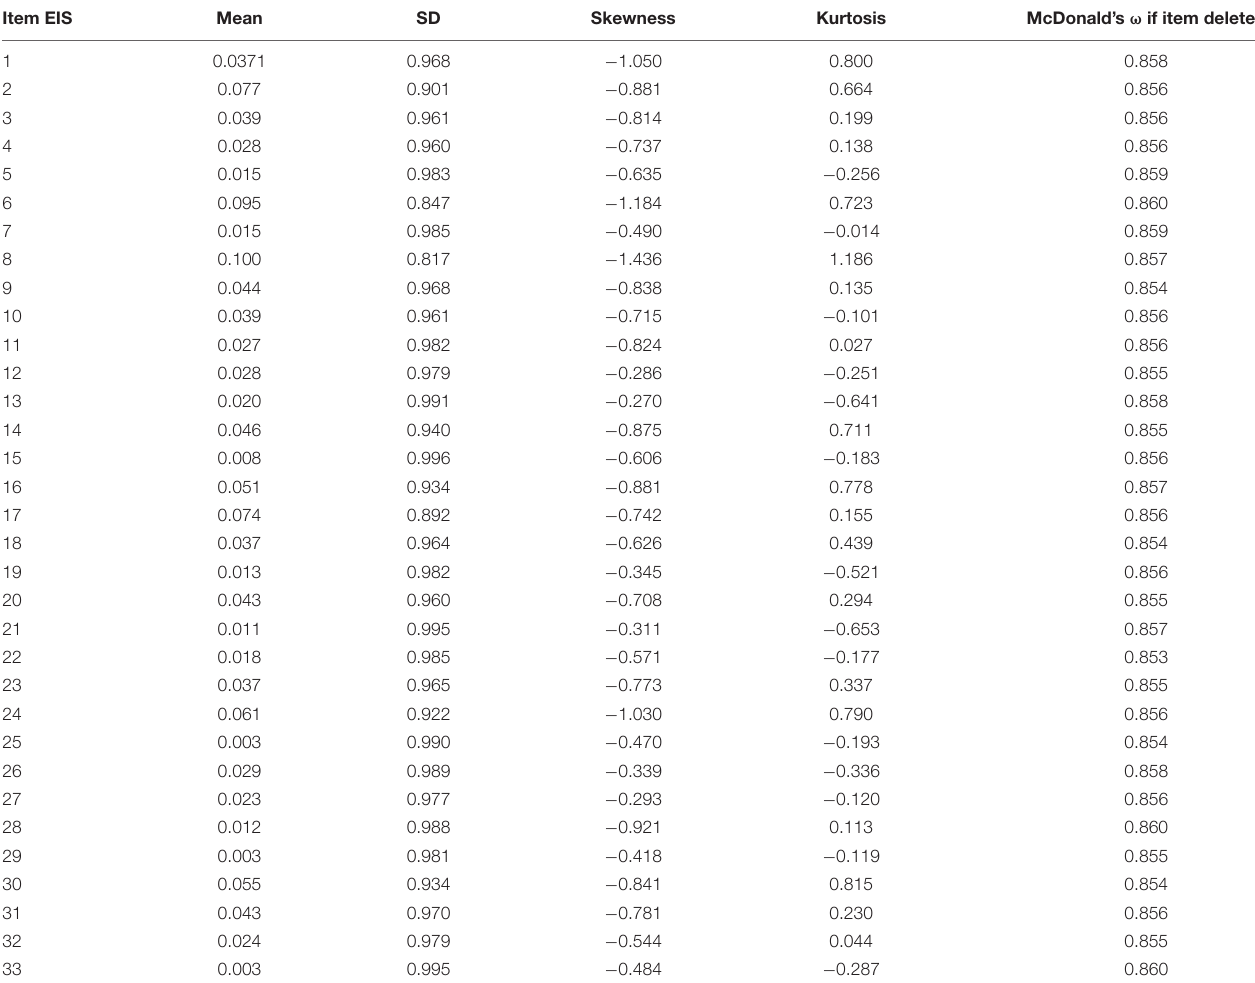
TABLE 1 | Mean, standard deviation, normality indices, and internal consistency of the EIS ( N = 1725). Item